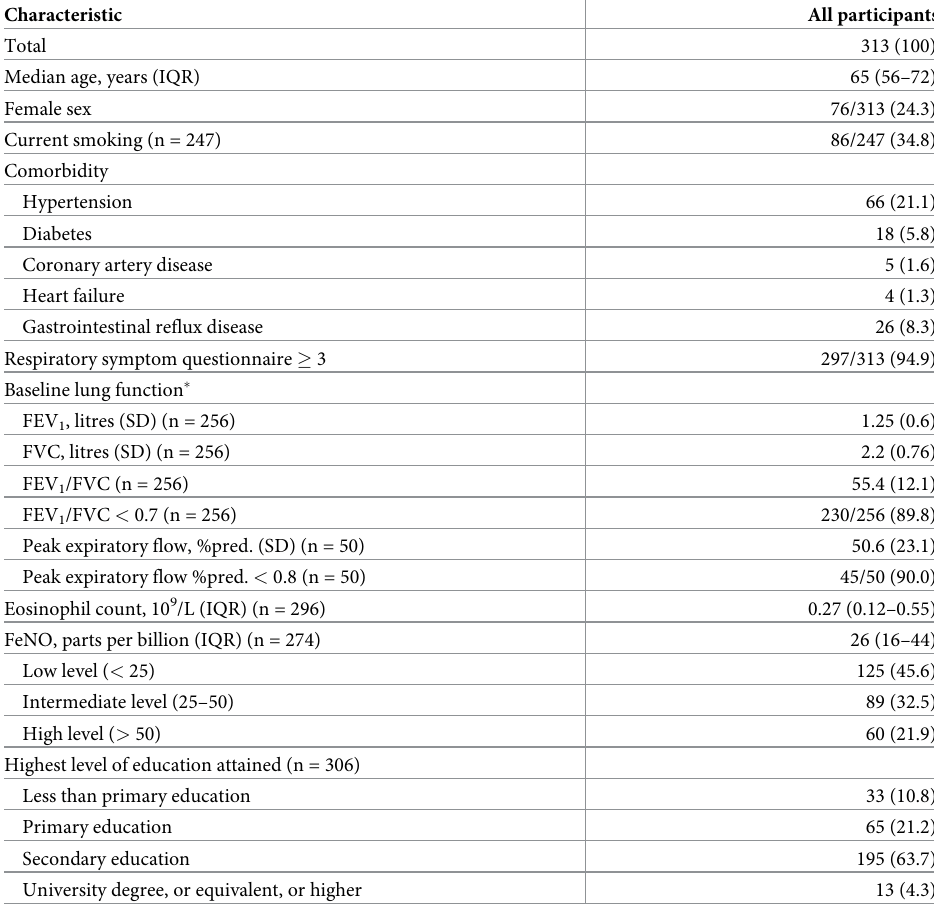
Table 1. Baseline characteristics of study